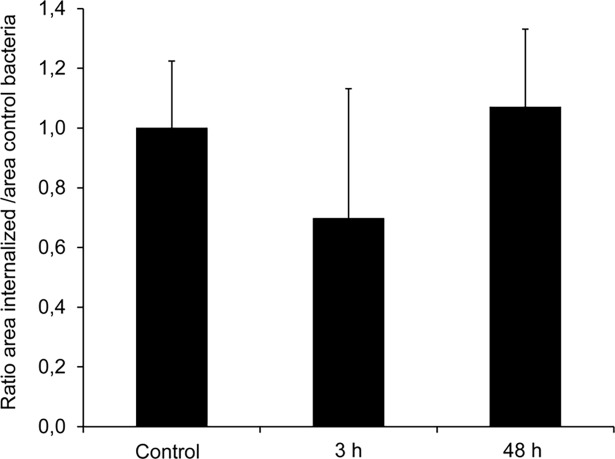
Single Reaction Monitoring (SRM) of BP0414 (MgtC).Relative abundance of BP0414 in extracellular bacteria (control), intracellular bacteria recovered 3 h post-infection (3 h), and intracellular bacteria recovered 48 h post-infection (48 h) are shown. Two independent biological replicates with two technical replicates each were analyzed. Values are expressed as ratios relative to the control. Data represent mean relative protein levels ± SD.